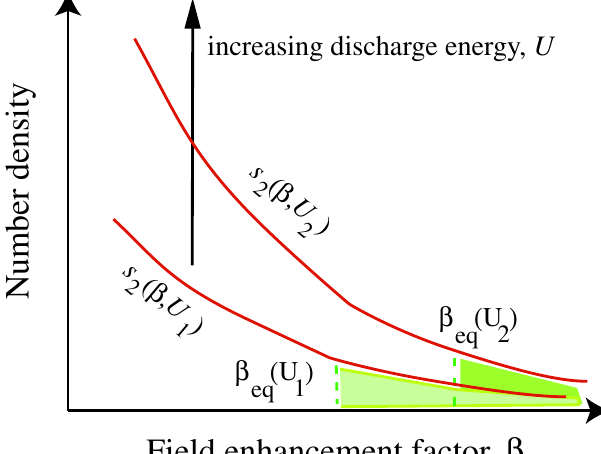
FIG. 4. (Color) Surface damage in a cavity must be approxi- mately proportional to the energy released to the walls in a discharge event. With more energy available, it is likely that more damage would be produced at high enhancement factors.